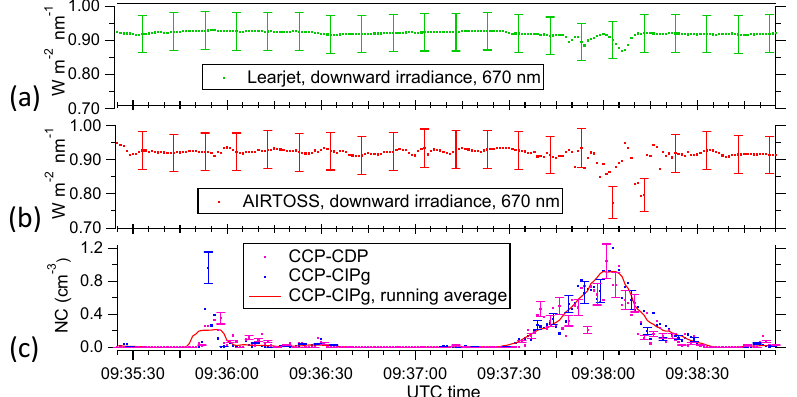
Figure 8. Downward spectral irradiance at 670 nm measured from the (a) Learjet and (b) AIRTOSS as well as the (c) number concentration (NC) measured on the AIRTOSS platform with the CCP-CDP (2–50µm) and the CCP-CIPg (15–960µm) instruments. The data were obtained at the highest flight leg and measured on 4 September 2013, where AIRTOSS flew at an altitude of around 9900m. The vertical bars indicate the error of the instruments, and the running average uses the boxcar smoothing algorithm with 10 repetitions.